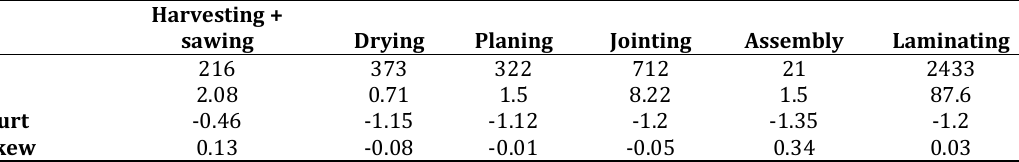
Table 2: Result of the Monte-Carlo simulation